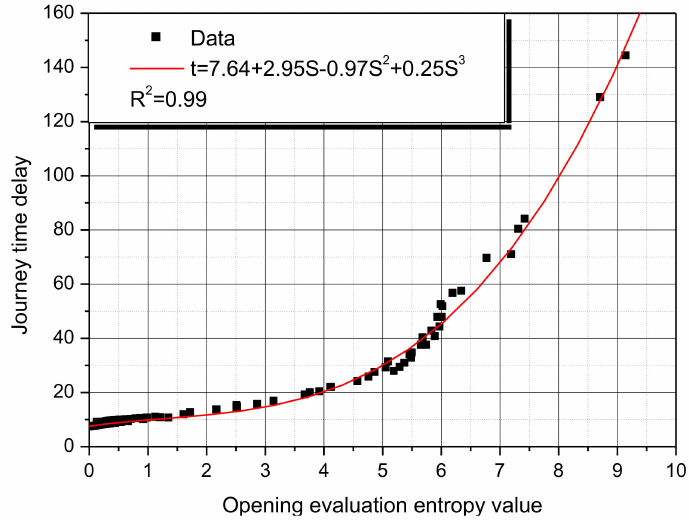
Figure 8. Relationship between the evaluation entropy and journey delay